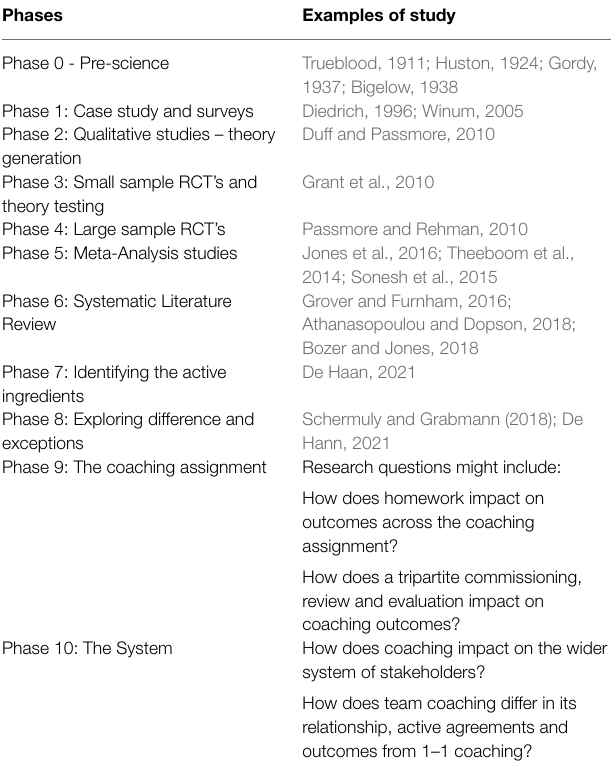
TABLE 4 | 10-phase model of coaching research.